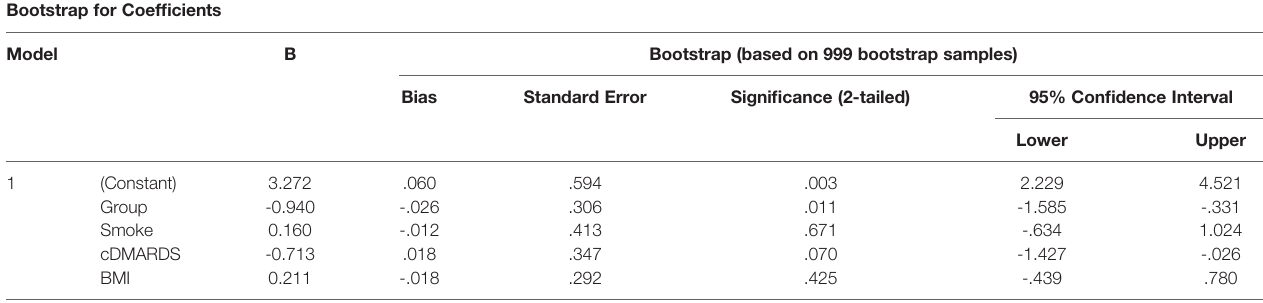
TABLE 2 | Bootstrapping analysis for pSTAT3 in CD4+ Th1